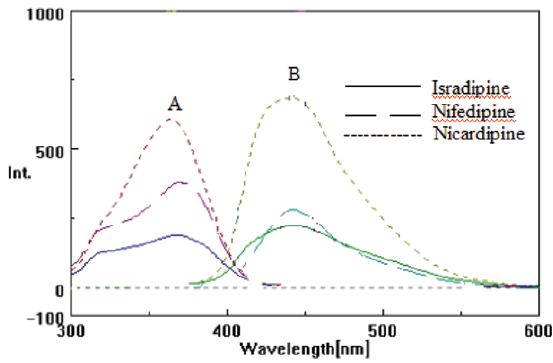
Figure 2. Fluorescence spectra of isradipine (1μg ml -1 ), nifedipine (1 μg ml -1 ) and nicardipine (0.8 μg ml -1 ) after reduction with Zn/HCl. A)